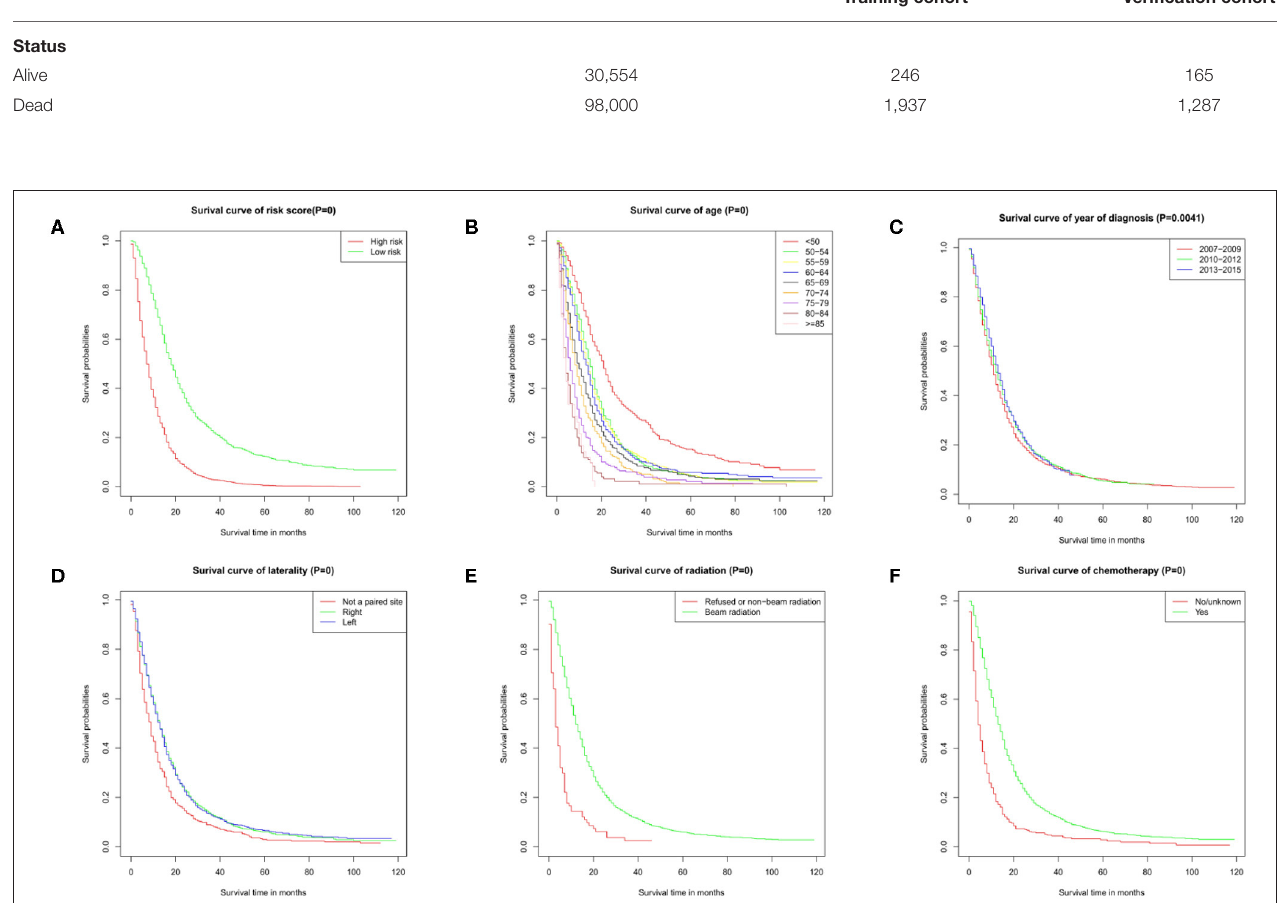
FIGURE 2 | Survival curves. Survival curve of (A) risk score, (B) age, (C) year of diagnosis, (D) laterality, (E) radiation, and (F) chemotherapy. These graphs show the impact of each subtype on survival. P = 0 means P < 0.001.